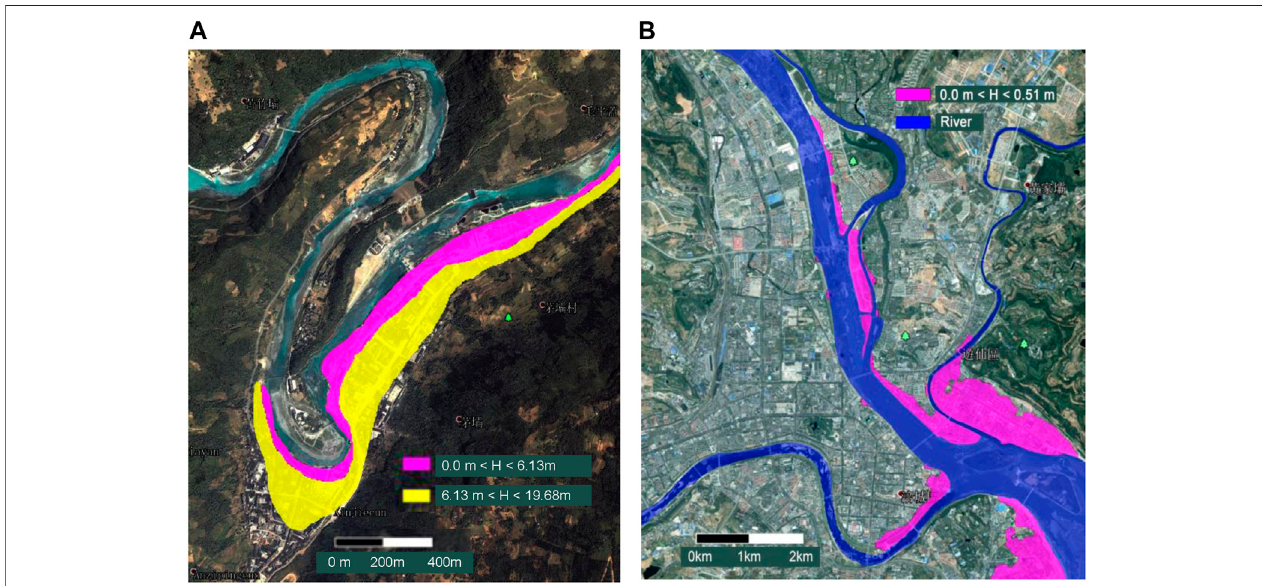
FIGURE 8 | The inundation maps of Beichuan Town and Mianyang City: (A) Scenarios 1 (the maximal water level (cid:2) 6.13 m) and 2 (the maximal water level (cid:2) 19.68 m) in Beichuan; (B) Scenario 2 (the maximal water level (cid:2) 0.51 m) in Mianyang (Mianyang is not fl ooded in Scenario 1).